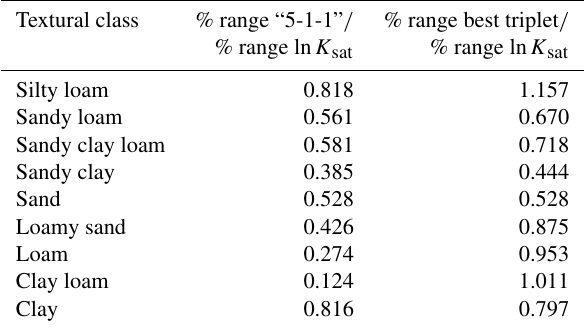
Table 6. Comparison of parametrizing power of (IE,“5-1-1”) against IE calculated with other triplets. The ranges of variation of IE calculated with the different triplets are compared to the ranges of variation of K sat for the textural classes. The triplets are chosen to be the ones that gave the highest R 2 values at the linear regres- sions for K sat